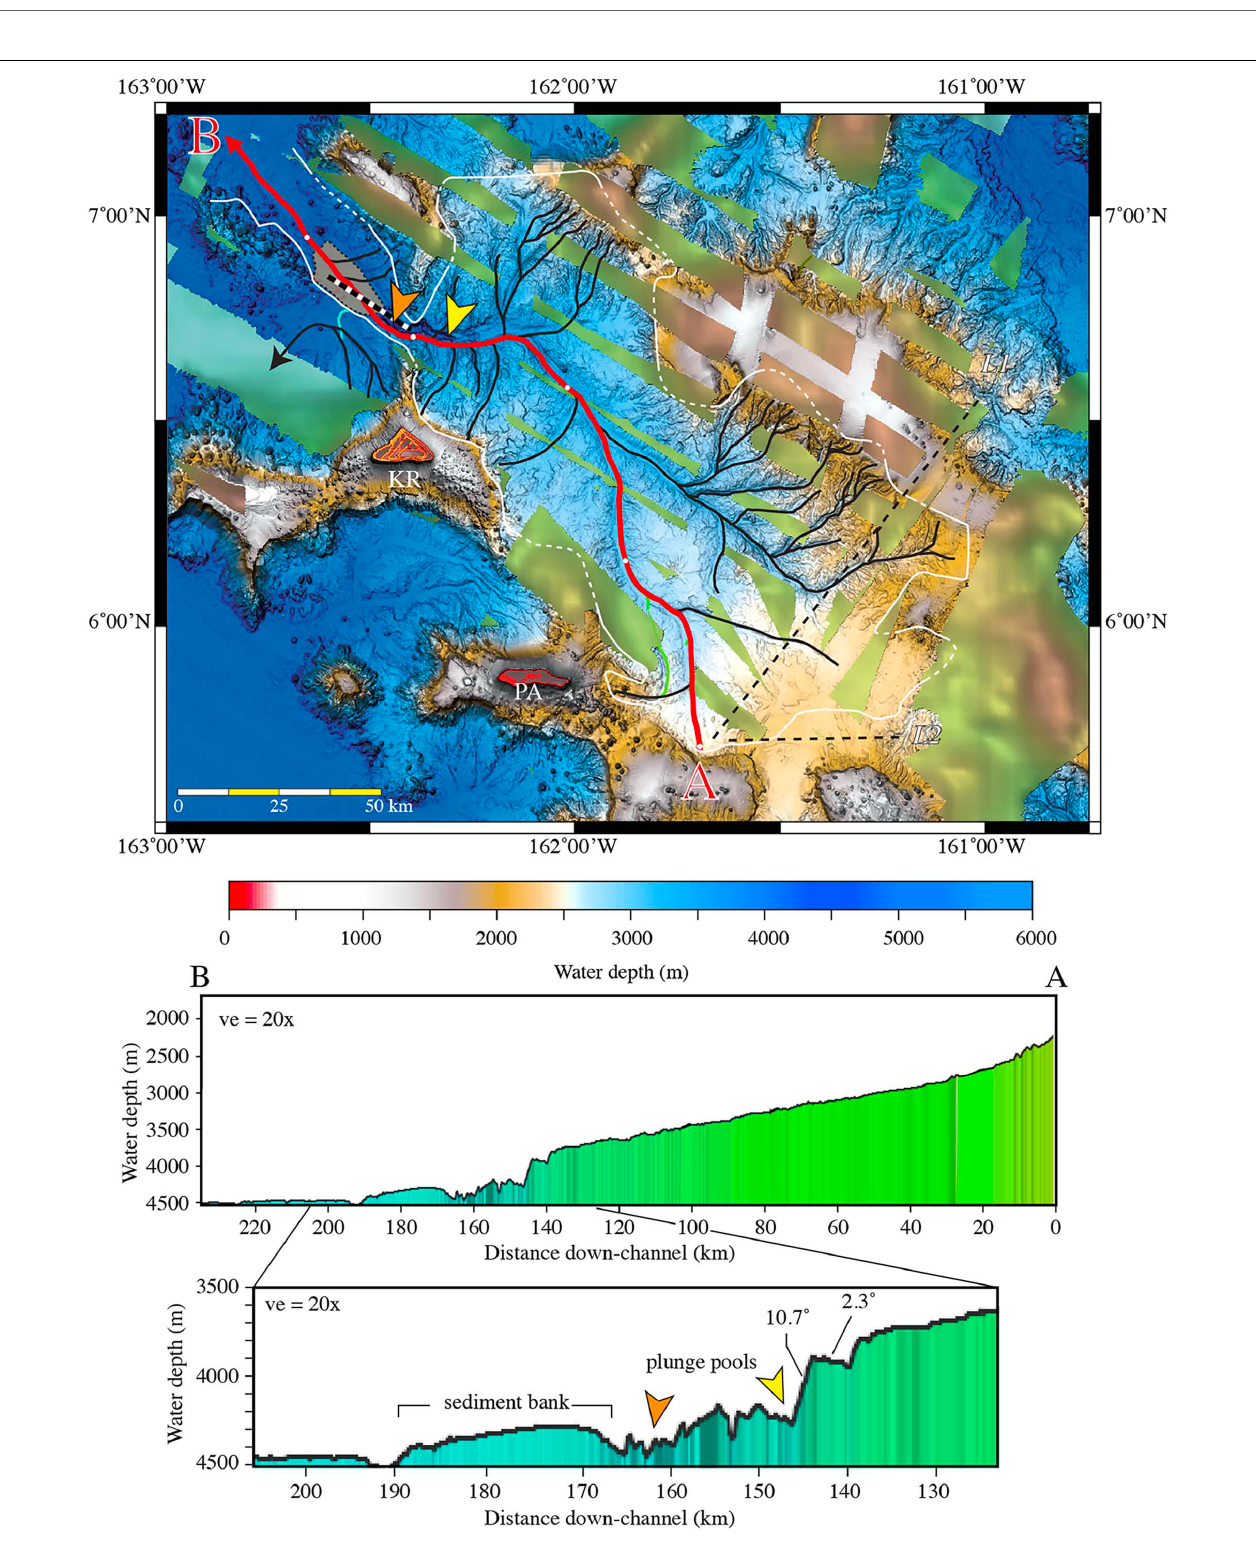
FIGURE 5 | A Map view of multibeam bathymetry of the upper 240 km of the main channel reach of system CS-A. Upper main channel in red with white 50-km distance markers; tributaries in black. Profile A–B shows down-channel profile of the upper main channel with expanded profile below. Yellow and orange arrowheads show locations of plunge pools, light brown area is location of sediment bank. Heavy black and white dashed line is location of subbottom line L473 (see Figure 8 ). KR and PA are locations of Kingman Reef and Palmyra Atoll, respectively. L1 and L2 are locations of Lyle et al. (2016) high-resolution multichannel seismic profiles.